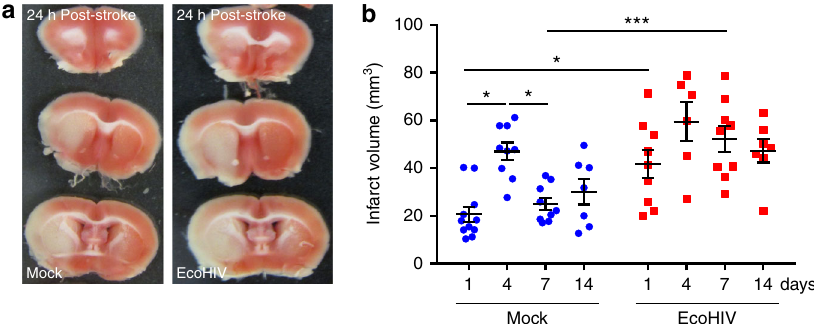
Fig. 1 EcoHIV increases infarct size and delays tissue recovery. Mice were infected with EcoHIV (1 µ g of HIV p24), and ischemic stroke was induced 3 weeks post infection by the occlusion of the middle cerebral artery. a TTC staining of brain sections of mock- and EcoHIV- infected mice 24 h post stroke. White areas denote tissue damage. b Calculated infarct volume for days 1, 4, 7 and 14 post-stroke in either mock- or EcoHIV infected mice; n = 6 – 12 mice per group, 3 independent experiments. Data presented as mean and SEM with individual data points. Source data are provided as a Source Data fi le. * p < 0.05; ** p < 0.01; one-way ANOVA, followed by Tukey multiple